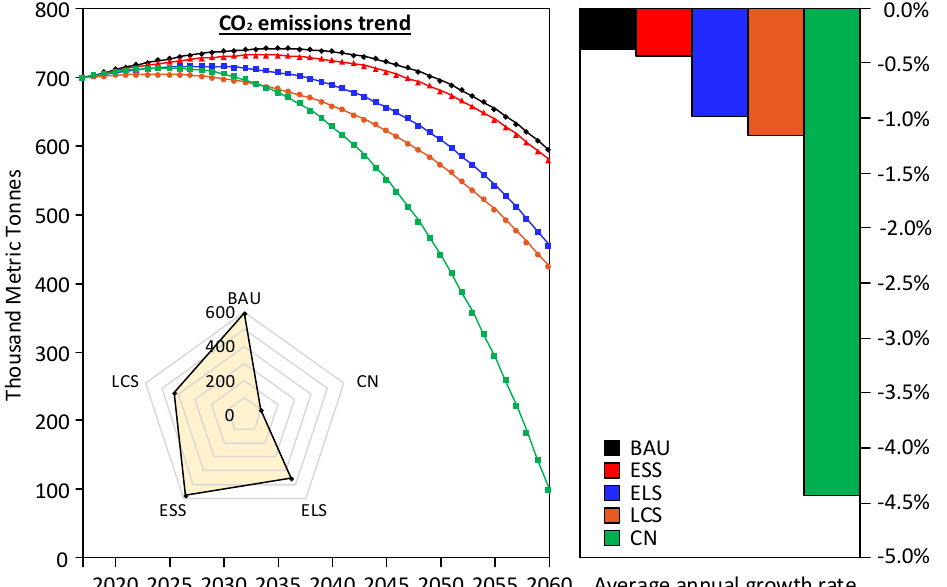
Figure 3. CO 2 emissions trend of the urban transportation sector in Jilin. The line chart ( left ) shows the trends in CO 2 emissions from 2017 to 2060 under five scenarios for the transport sector. The bar chart (right) shows the average annual growth rate of CO 2 emissions from the transport sector under different scenarios. The radar map (left) shows the state of CO 2 emissions in the transport sector under different scenarios in 2060.